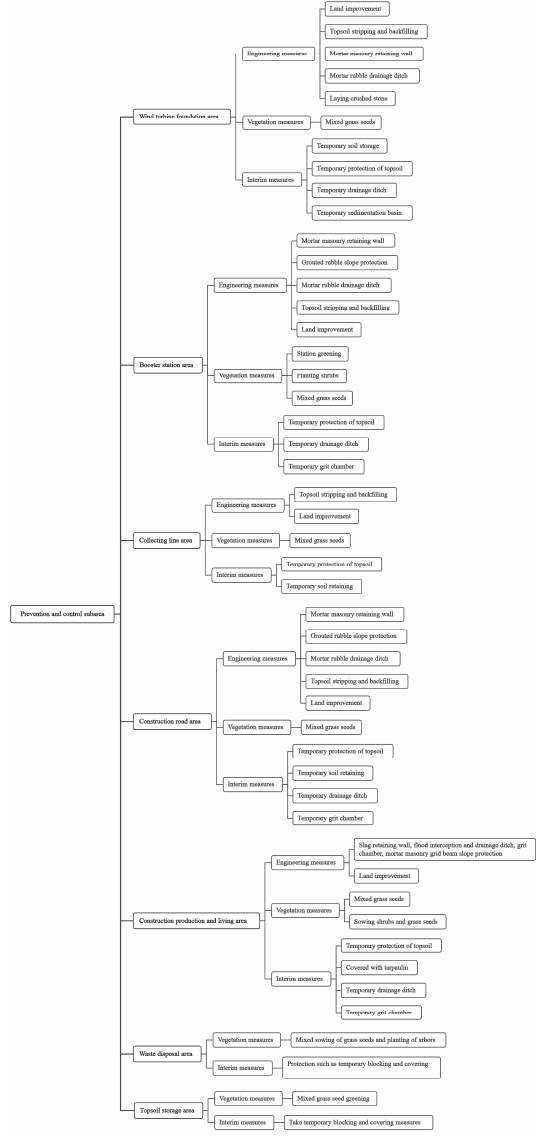
Figure 16. Water and soil loss prevention measures system.